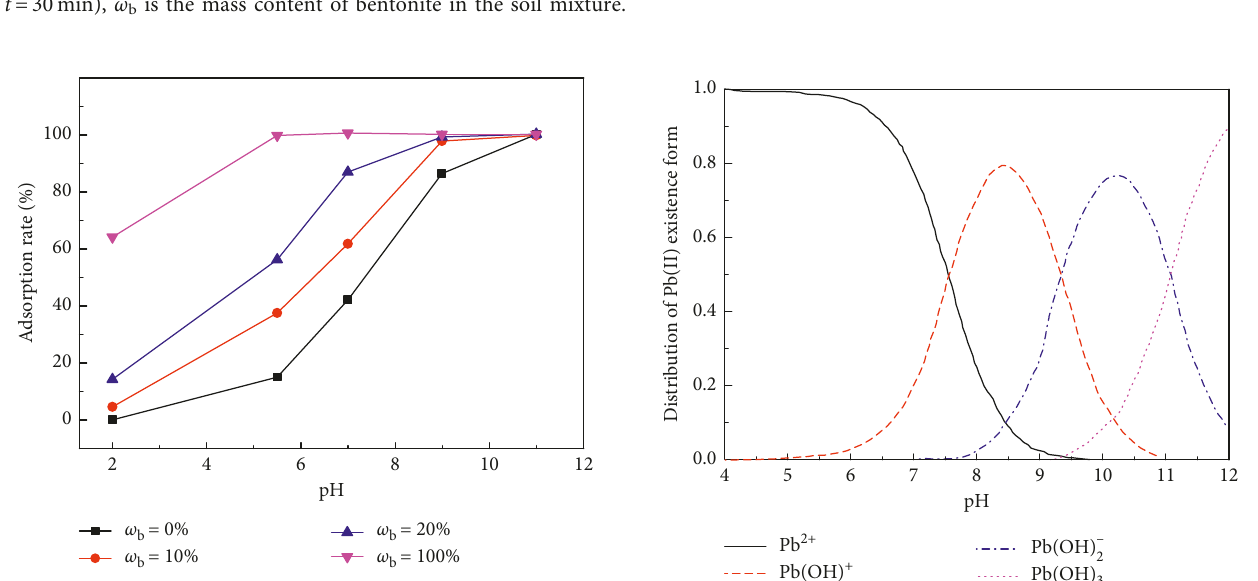
Figure 3: Influence of s / w on (a) equilibrium capacity of Pb(II) and (b) Pb(II) adsorption rate (pH